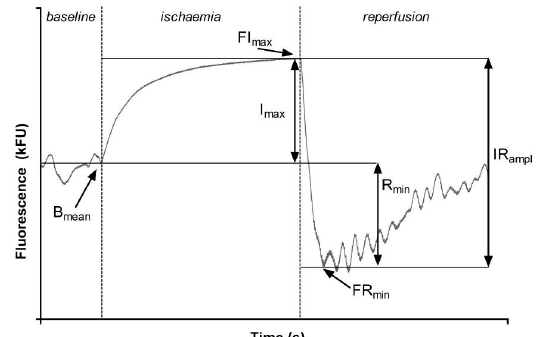
Figure 1. Parameters describing the Flow Mediated Skin Fluorescence. B mean —Mean value of the basal fluorescence; FI max —Maximal fluorescence during ischemia; FR min —The first minimal fluorescence value during reperfusion; I max —The net increase in fluorescence over the baseline during ischemia; IR ampl —The amplitude of fluorescence change during ischemia and reperfusion; R min —The net reduction in fluorescence below the baseline. Reprinted from Bugaj et al.